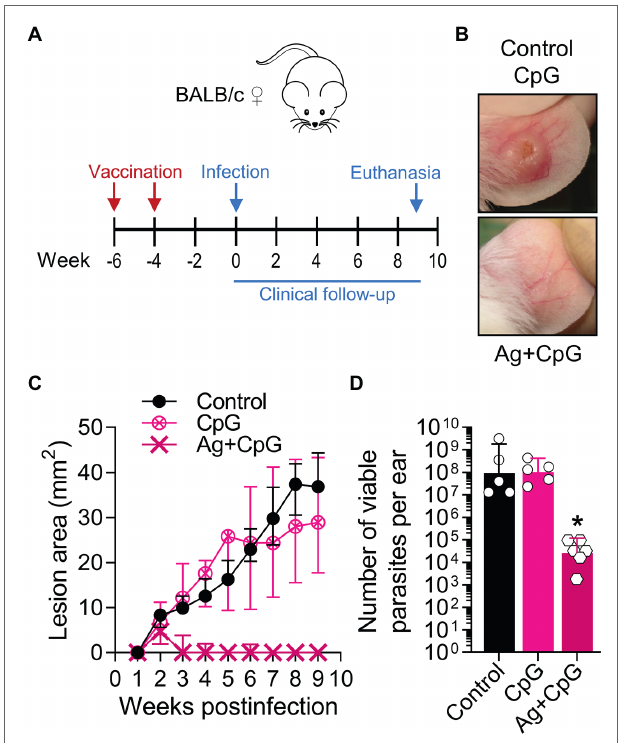
FIGURE 7 | Using the L(V)p -BALB/c model to investigate immunological interventions. BALB/c mice were vaccinated with Ag + CpG (12.5 μ g/6.25 μ g sc in the base of the tail) and boosted with the same dose 2 weeks later, to be infected in the ear dermis with 10 5 L(V)p stationary promastigotes 4 weeks after the boost (A) . Mice were followed weekly to monitor lesion growth. Mice injected with CpG (6.25 μ g) or PBS were used as controls. Representative photographs of the ears from Ag + CpG-vaccinated mice and controls at the week 6 postinfection are shown (B) . The kinetics of lesion progression after infection is graphed (C) as the median ± interquartile range. From week 2 postinfection, there was a statistically significant difference between control and Ag + CpG. The number of viable parasites at the site of infection was determined at the end of the experiment (week 9 postinfection) by a limiting dilution assay and graphed (D) as the geometric mean ± 95%CI. n = 5–6 mice. A similar efficacy of Ag + CpG has been observed in repetition experiments, with more than 90% of mice protected from clinical disease and a 10 3 –10 6 - fold reduction in parasitic loads. wpi: weeks postinfection. * p < 0.05 (Two-way ANOVA with Geisser–Greenhouse correction and Bonferroni’s multiple comparisons post-hoc test for multiple comparison through time; Kruskal– Wallis test with Dunn’s multiple comparison post-hoc